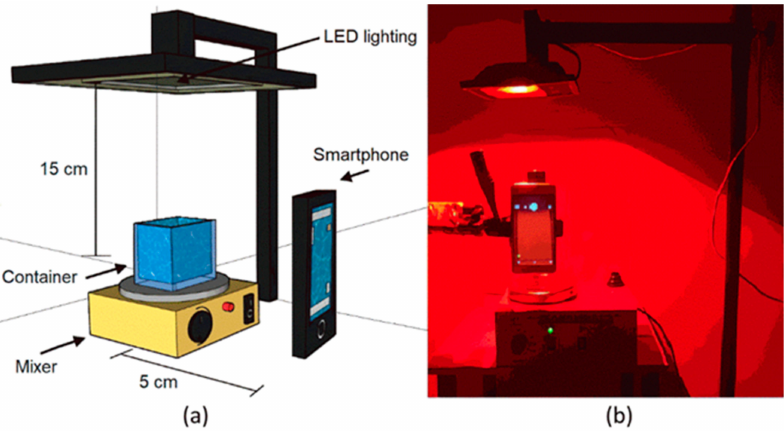
Figure 5. Experimental setup: ( a ) scheme of the experimental setup; ( b ) experimental setup used.